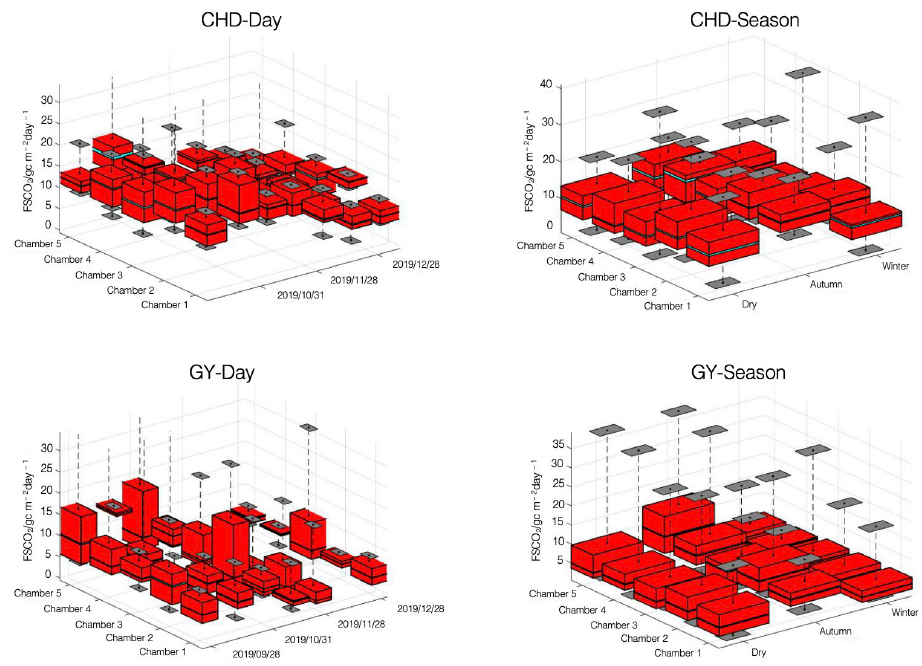
Figure 3. The monthly and daily variation of field-measured FSCO 2 in GY and CHD sites.